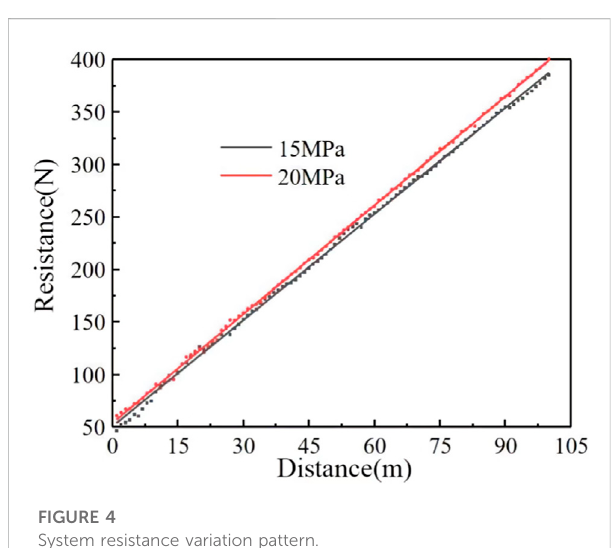
FIGURE 4 System resistance variation